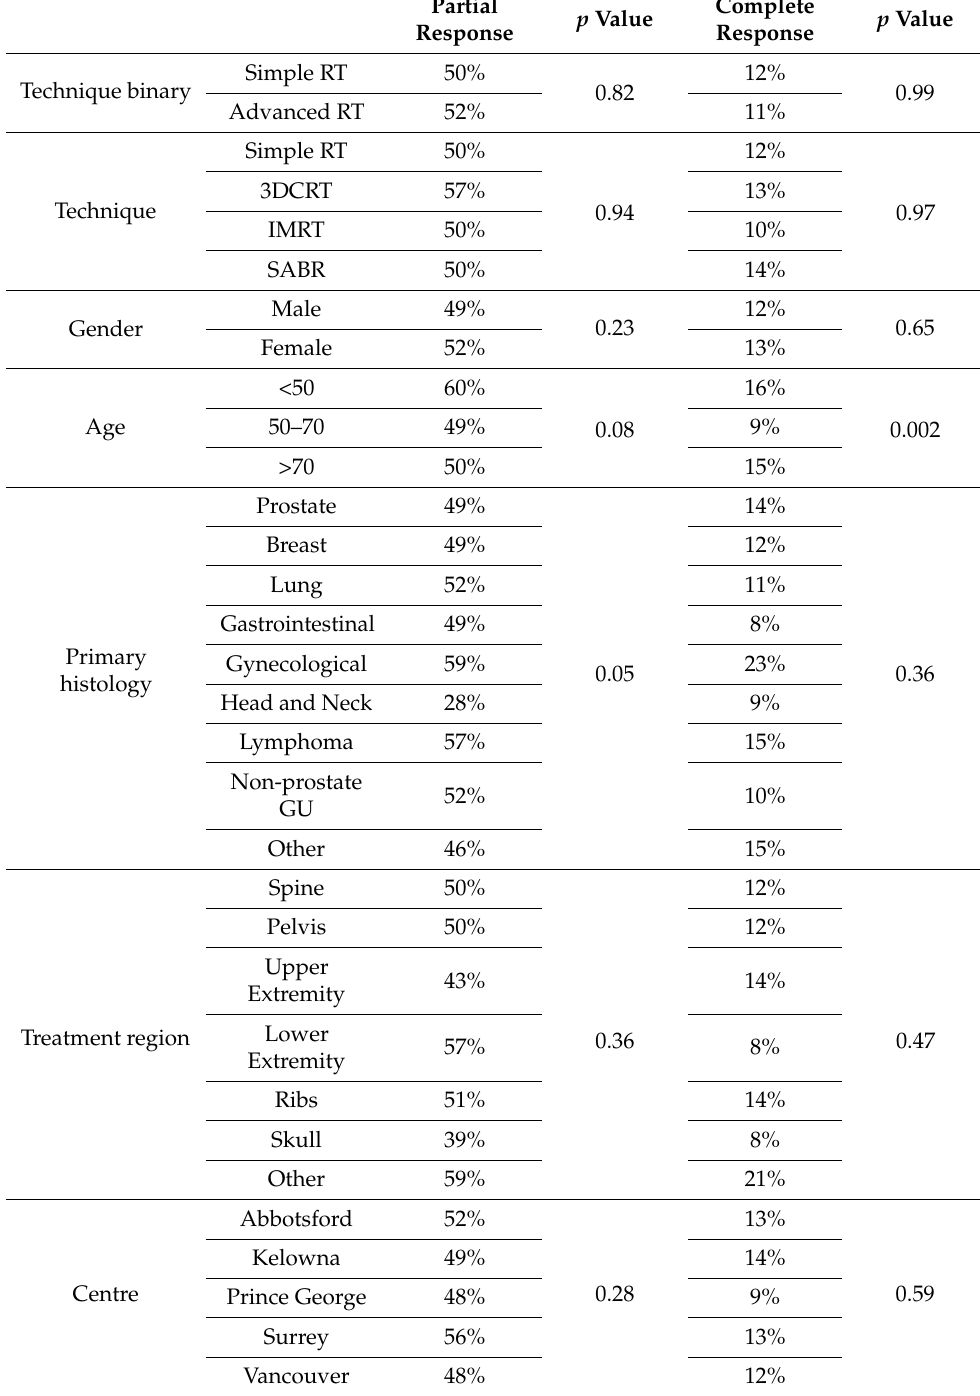
Table 2. Partial response and complete pain response by patient